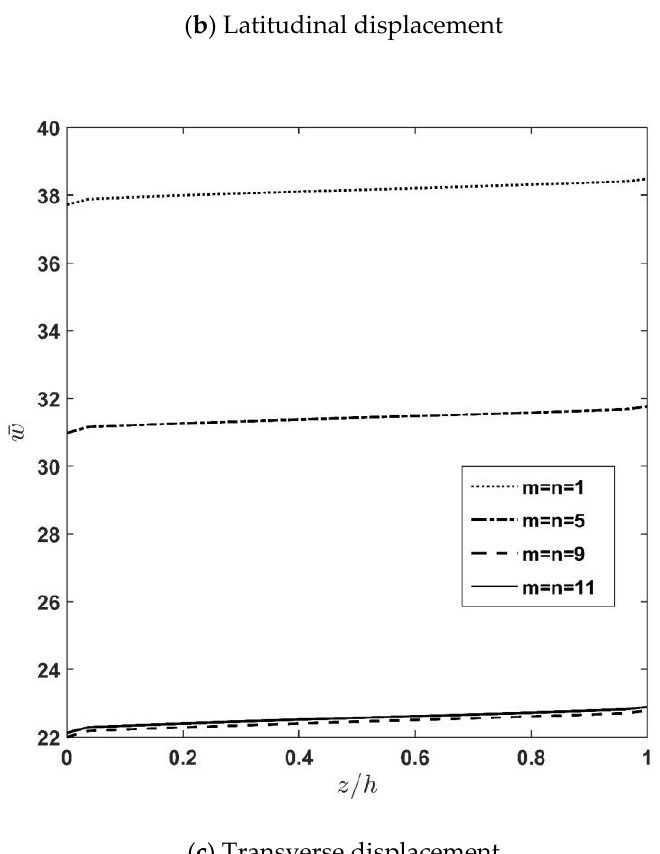
Figure 2. Through-thickness distribution of transverse normal stress, latitudinal displacement, and deflection of plate for different half wave numbers (m, n).